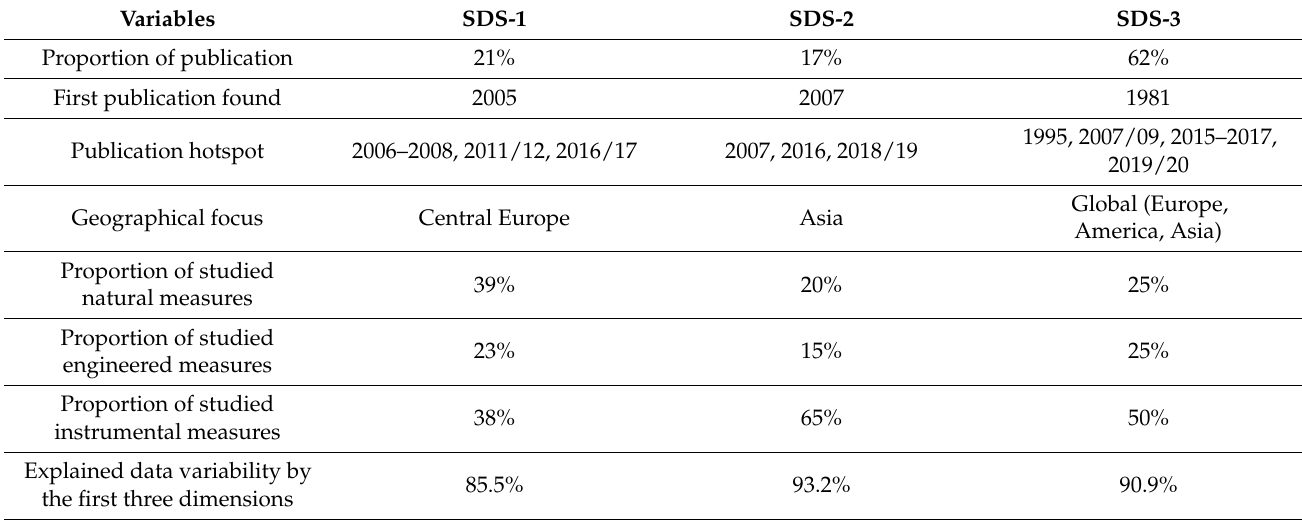
Table 4. Overview of sub-data set (SDS) information (N = 442) used in